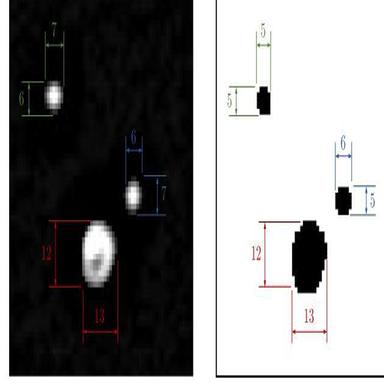
Size comparison of individual voids in the original and thresholded pictures for the calibration of the intensity threshold value; numbers represent size in pixels.